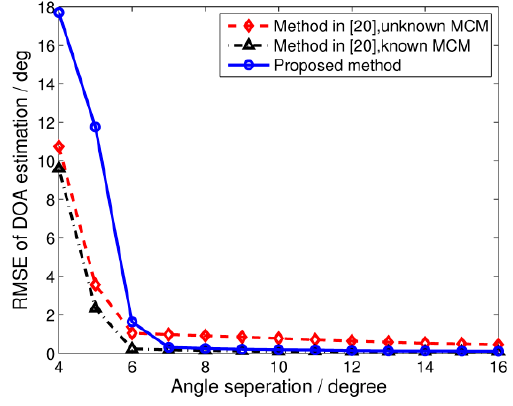
Figure 5. RMSE of DOA estimation versus the angle separation of incident signals. SNR = 0 dB, snapshots = 64.